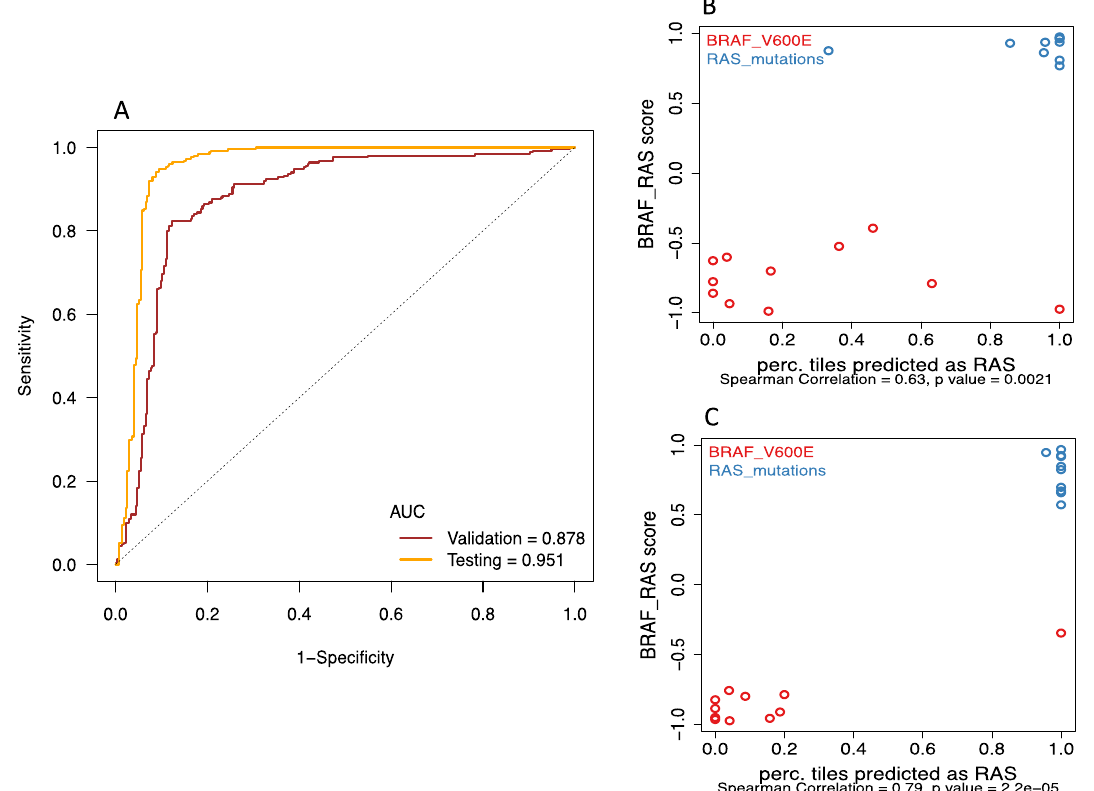
Figure 2. Deep-learning models successfully discriminated BRAF V600E and RAS mutation of papillary thyroid carcinomas from histological images. ( A ) Receiver Operating Characteristic (ROC) curves showed that area under curve (AUC) values for the best model were 0.878 for validation and 0.951 for final testing subsets. (B&C) The correlations between the probability of accurate prediction per tile image and BRS (BRAF-RAS score) were significant in both ( B ) validation (Spearman correlation rho = 0.63, p = 0.002) and ( C ) final testing subsets (Spearman correlation rho = 0.79, p < 0.001).